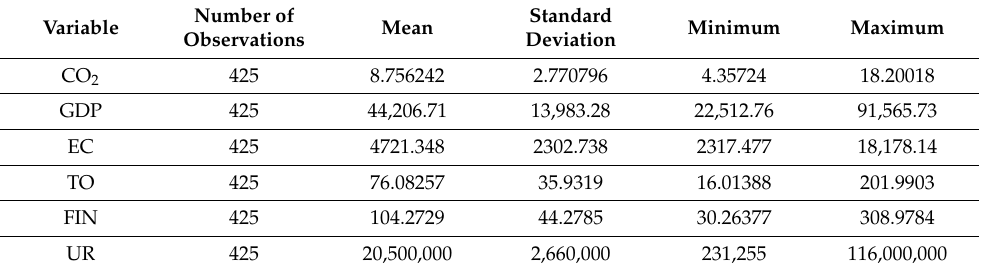
Table 2. Descriptive statistics.